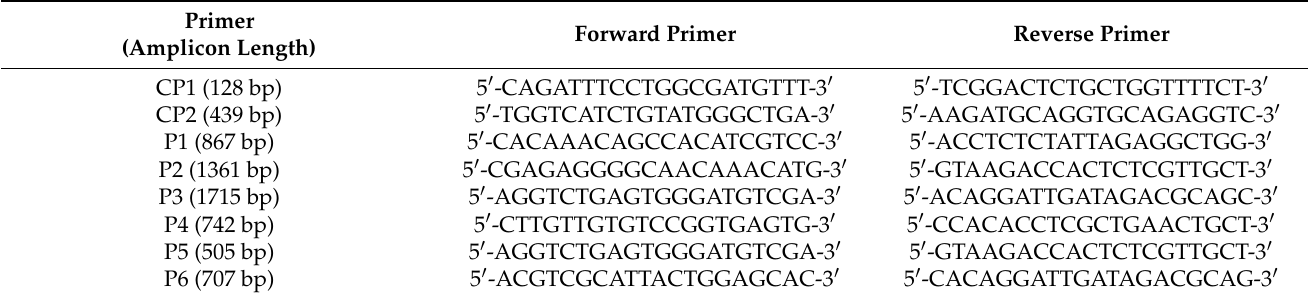
Table 1. Sequences of primers used for the amplification of ToMV SL-1 (bp—base